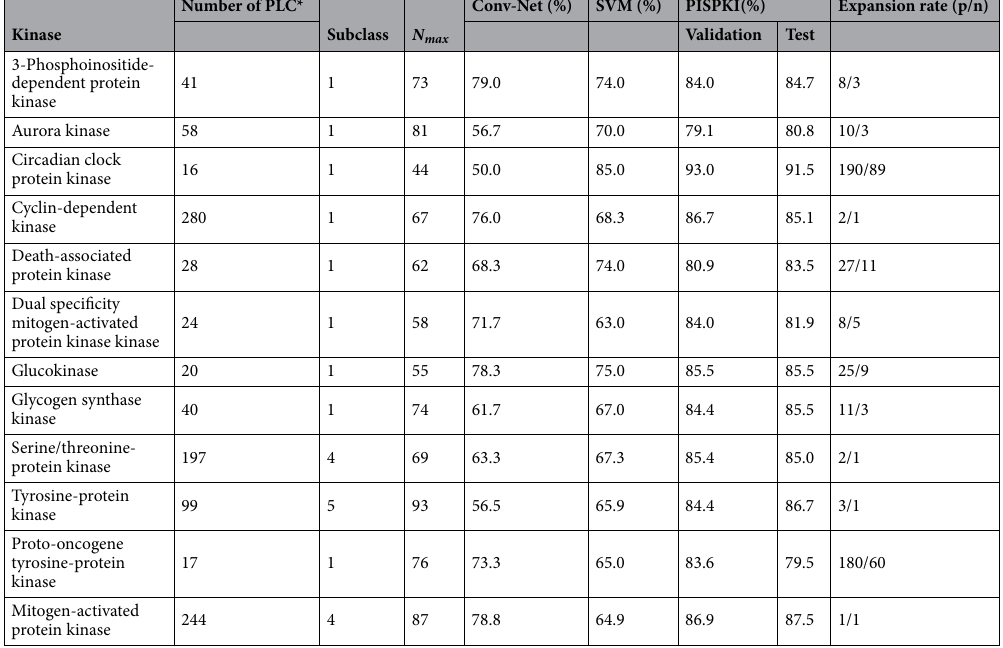
Table 2. Comparison of the validation and test (%) performance of different